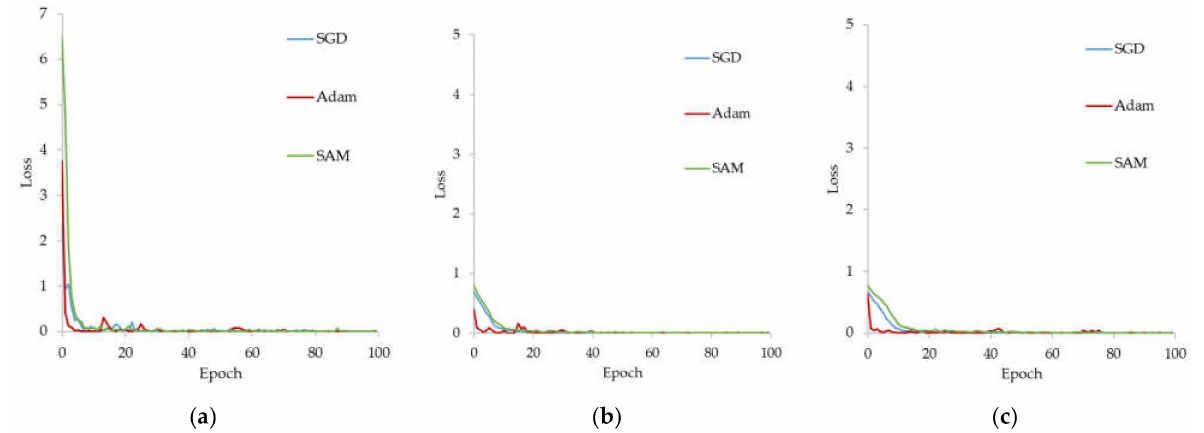
Figure 13. Training losses of CNN classifiers on the EUR dataset with various optimization methods: